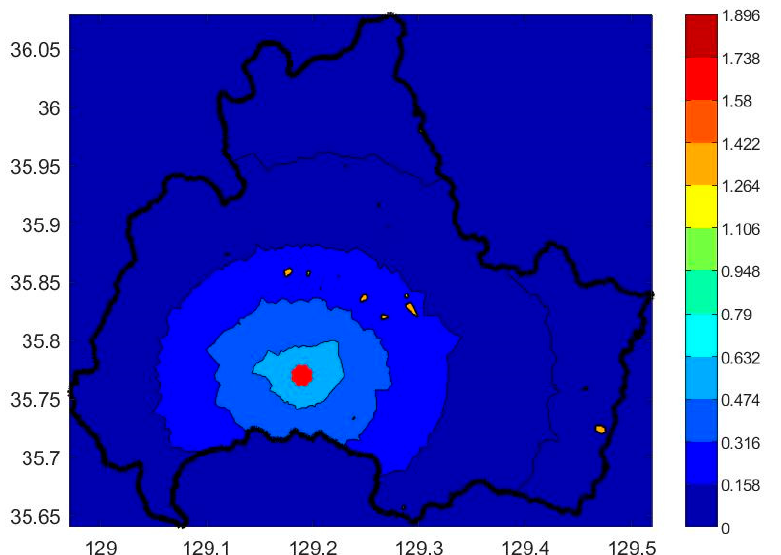
Figure 11. Map for the maximum displacement estimation based on the traditional design standard for earthquake of 0.147 g in Gyeongju.